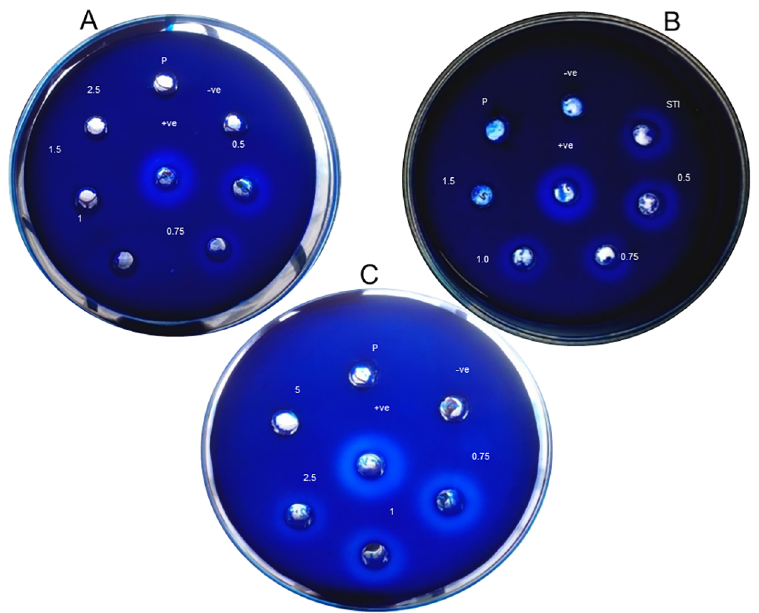
Fig 2. Disc diffusion plate assay showing T . cordifolia stem proteins’ effect on trypsin and α -chymotrypsin activity. The wells contained 5 ug of enzyme with varying amounts of proteins. A: Stem proteins incubated with trypsin; B: Both stem proteins and STI incubated with trypsin. C: Stem proteins incubated with α -chymotrypsin. +ive, 5 μ g enzyme; -ive, 50 mM Tris-HCl buffer (pH 8.0); P, Protein sample (5 μ g); 5, 5 μ g enzyme + 5 μ g protein (E:S = 1:1); 2.5, 5 μ g enzyme + 2.5 μ g protein (E:S = 2:1); 1.5, 5 μ g enzyme + 1.5 μ g protein (E:S = 3.33:1); 1, 5 μ g enzyme + 1 μ g protein (E:S = 5:1); 0.75, 5 μ g enzyme + 0.75 μ g protein (E:S = 6.67:1); 0.5, 5 μ g enzyme + 0.5 μ g protein (E:S = 10:1); STI, 5 μ g enzyme + 1.5 μ g Soybean Trypsin